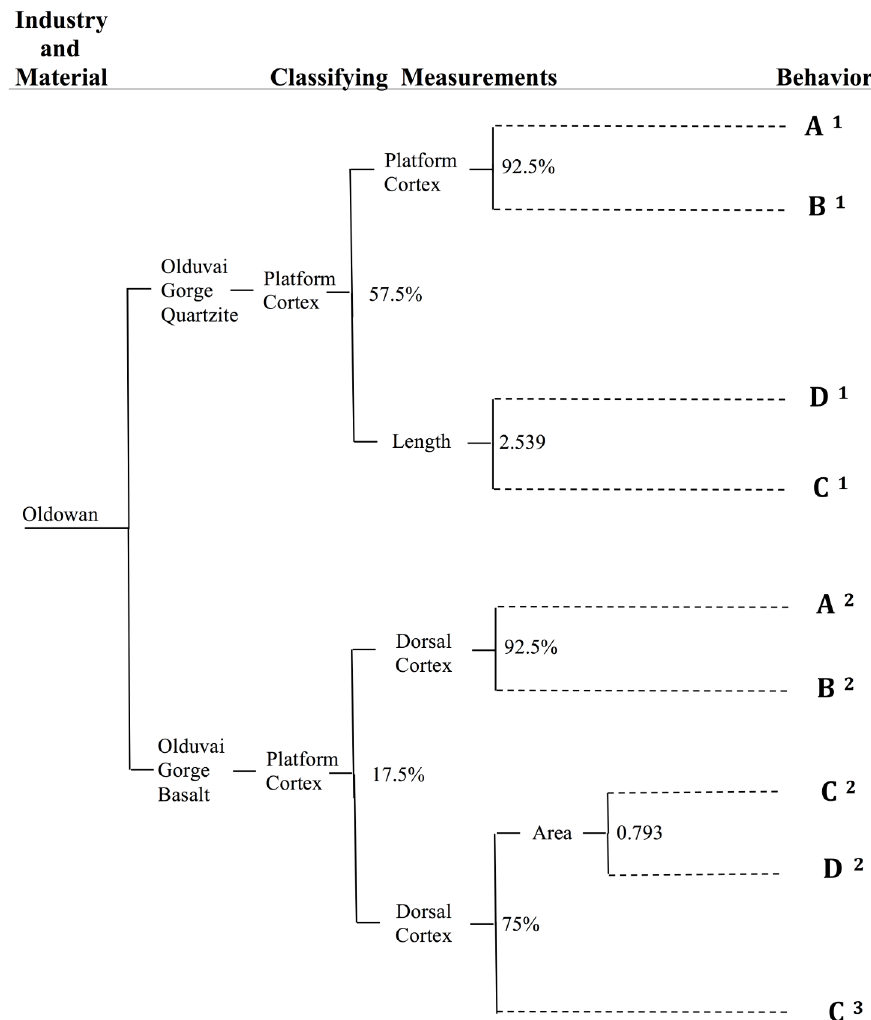
Fig 4. Behavioral classification for Oldowan artifacts produced on Olduvai Gorge basalt and quartzite raw materials. At each junction of the classification tree, if a given measurement is equal to or larger than the listed value, then the classification moves up the tree; if a given measurement is less than the listed value at the junction, then the classification moves down the tree until an ultimate behavioral classification is reached. For Olduvai Gorge quartzite and basalt, dorsal and platform cortex account for a large amount of the variation leading to classification. This relationship may or may not continue for other raw materials utilized at different Oldowan sites and is expected to vary in other